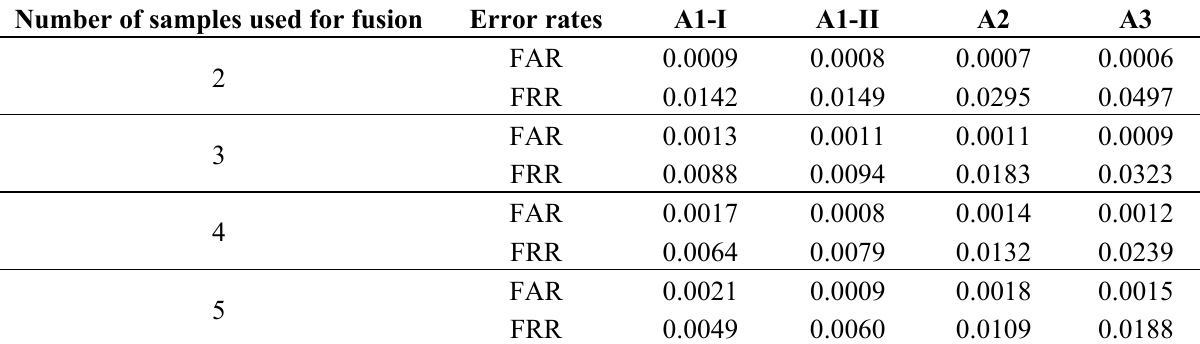
Table 9. Best performance (operation points closest to the performance target FRR ≤ 0.01 @ FAR = 0.001)—multi-sample-instance (left and right index fingers) fusion.